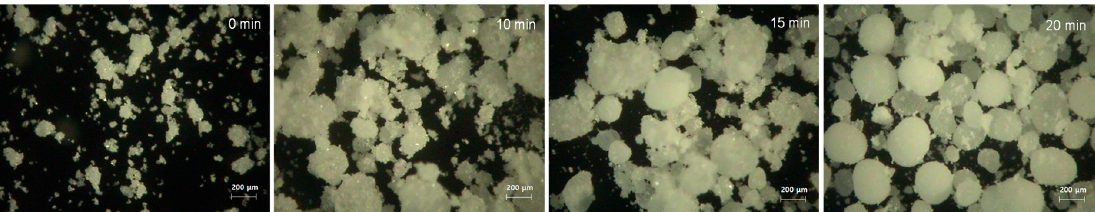
Figure 6. In-situ monitoring of spherical crystallization of CLP crystals at 0, 10, 15, and 20 min (from left to right), using video-microscope (600×). During monitoring, IPA/Hex [40:60, v/v] was used as an anti-solvent at 35 °C and a stirring speed of 500 rpm.